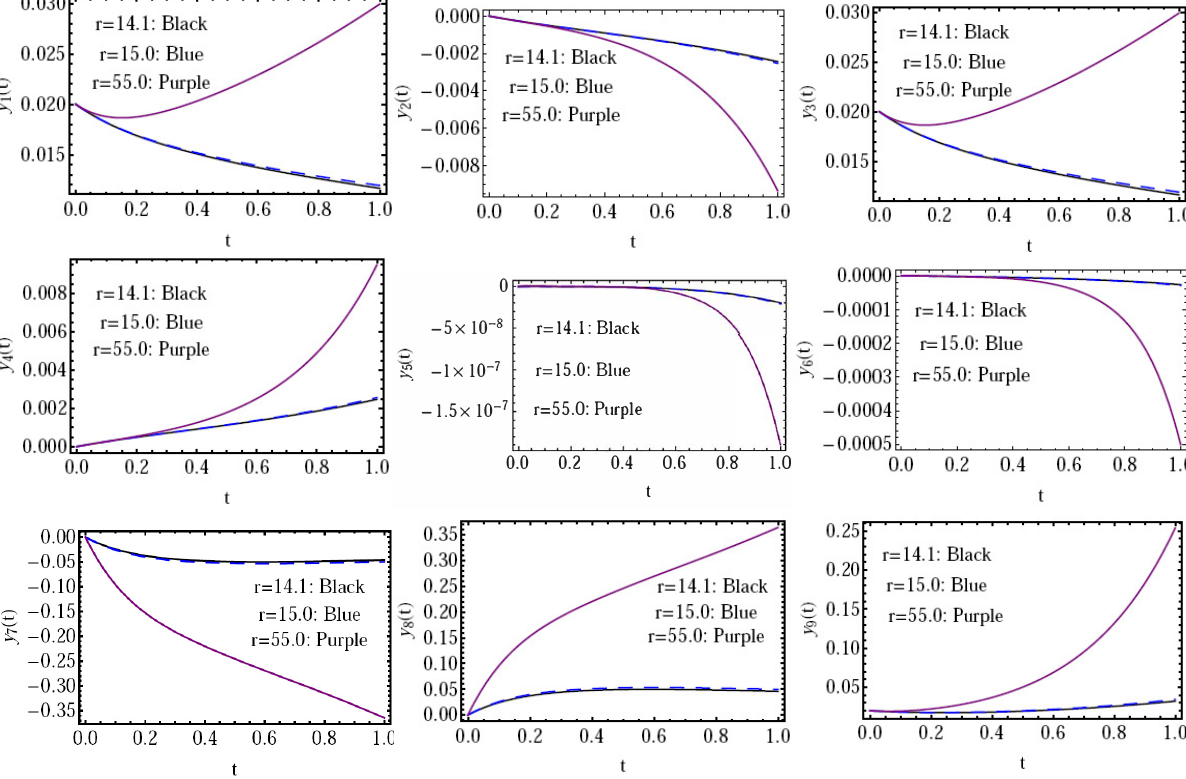
Figure 2. The approximate solution y i ( t ) , i = 1 ( 1 ) 9 against distinct values of r .